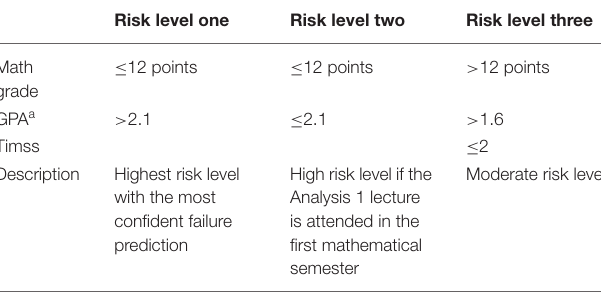
TABLE 11 | Description of three risk levels with especially unfortunate